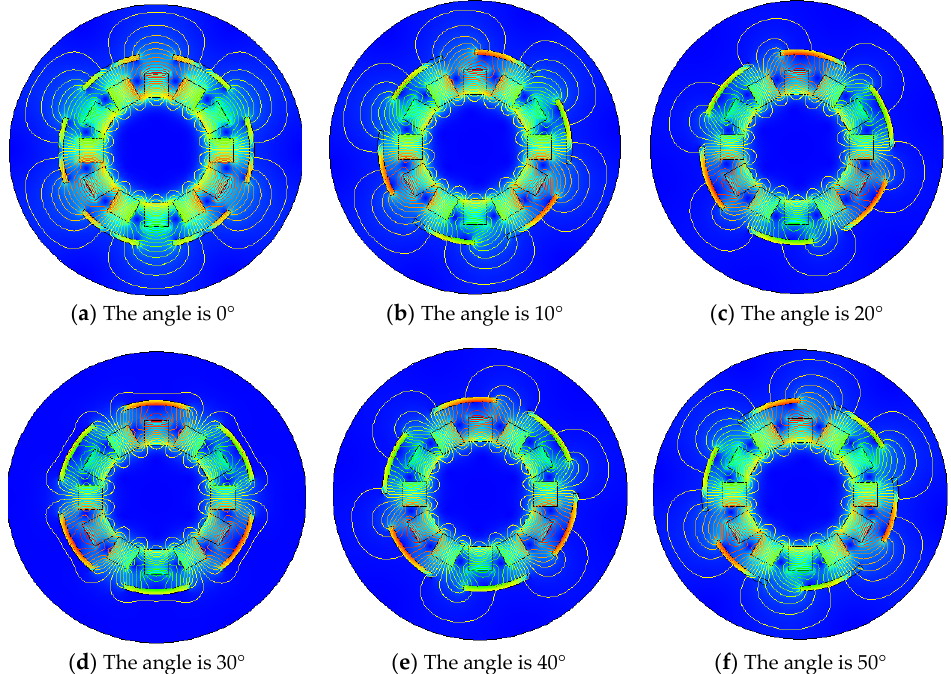
Figure 4. The magnetic field distribution diagram of iron sheet and Halbach array at different angles.